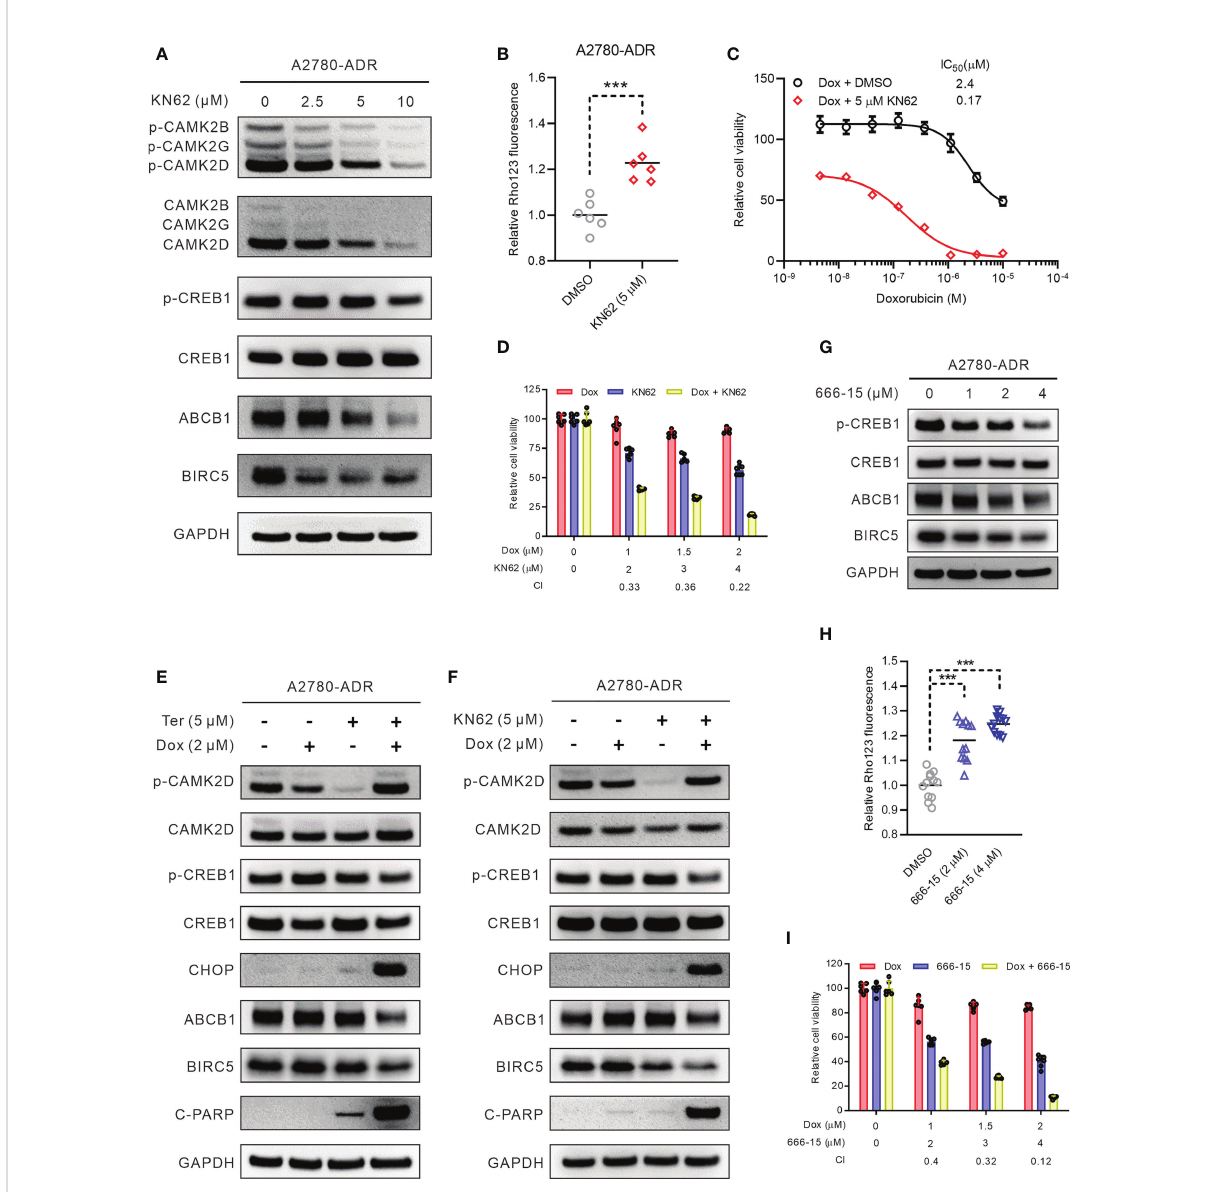
FIGURE 6 Inhibiting the CAMK2/CREB pathway reversed MDR in ovarian cancer cells. (A) Western blot of p-CAMK2 (T286), CAMK2 (pan), ABCB1, p-CREB1 (s133), CREB1, and BIRC5 in KN62-treated MDR ovarian cancer cells for 24 h. (B) Rho123 accumulation in MDR ovarian cancer cells treated